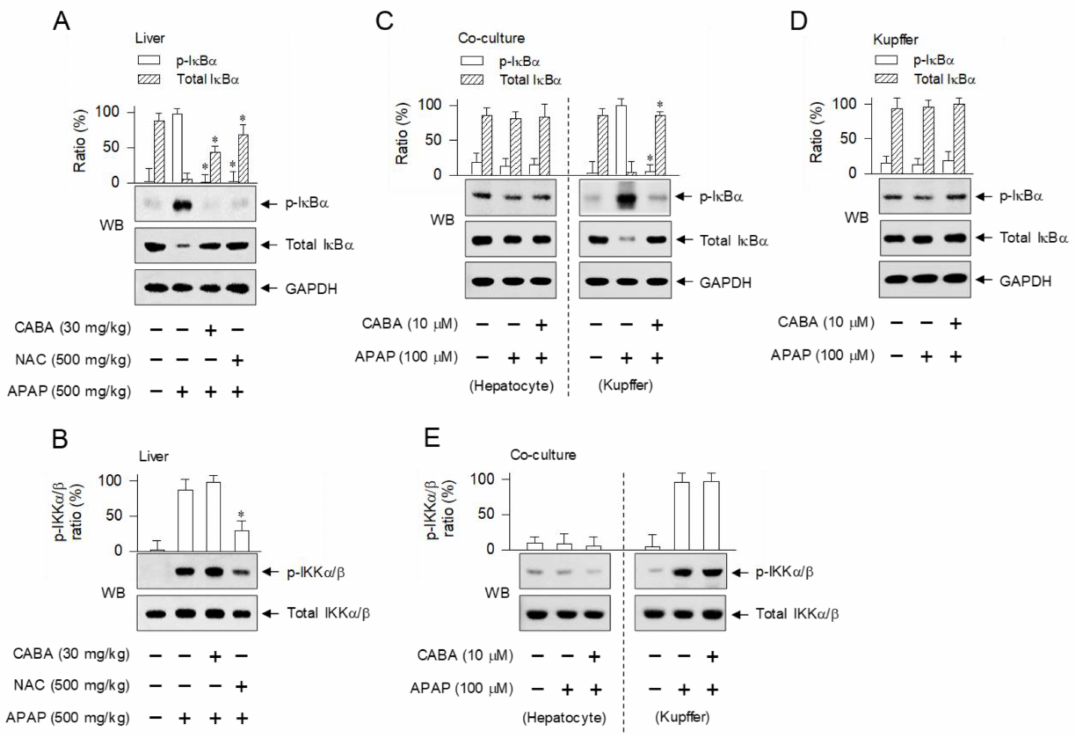
Figure 4. Effect of CABA on APAP-induced activation of IKK β . ( A , B ) C57BL/6 mice were treated with CABA at 1 h after APAP overdose. Liver lobules were biopsied at 15 h. ( C , E ) Co-culture be- tween primary hepatocytes and Kupffer cells was pretreated with CABA for 2 h and stimulated with APAP for 12 h in the presence of CABA. ( D ) Primary Kupffer cells were pretreated with CABA for 2 h and stimulated with APAP for 12 h in the presence of CABA. Protein extracts were resolved on an SDS-acrylamide gel by electrophoresis, and subjected to Western blot (WB) analysis with anti-p- I κ B α , anti-I κ B α , or anti-GAPDH antibody ( A , C , D ) and anti-p-IKK α / β or anti-IKK α / β antibody ( B , E ). Ratio (%) represents relative intensity of signals in WB. * p < 0.05 vs. APAP